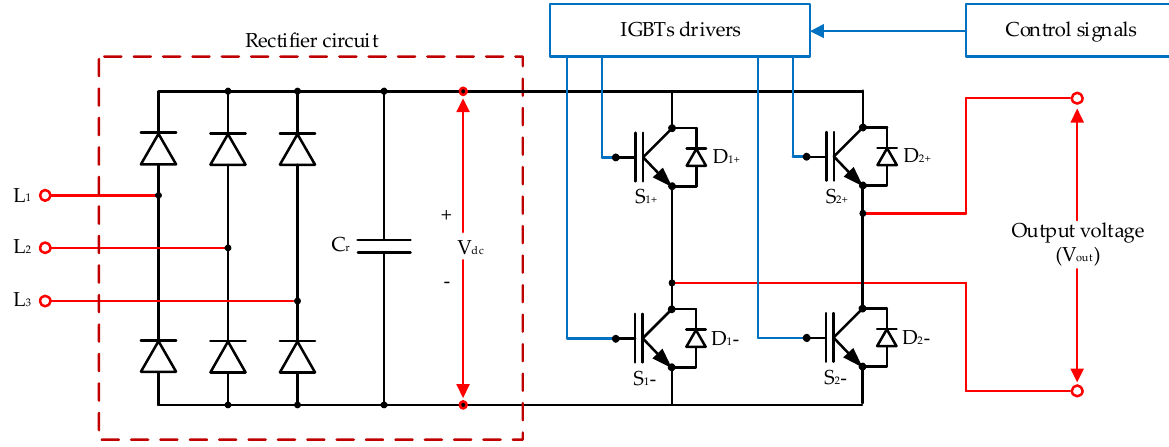
Figure 6. Low-voltage source power converter generator.